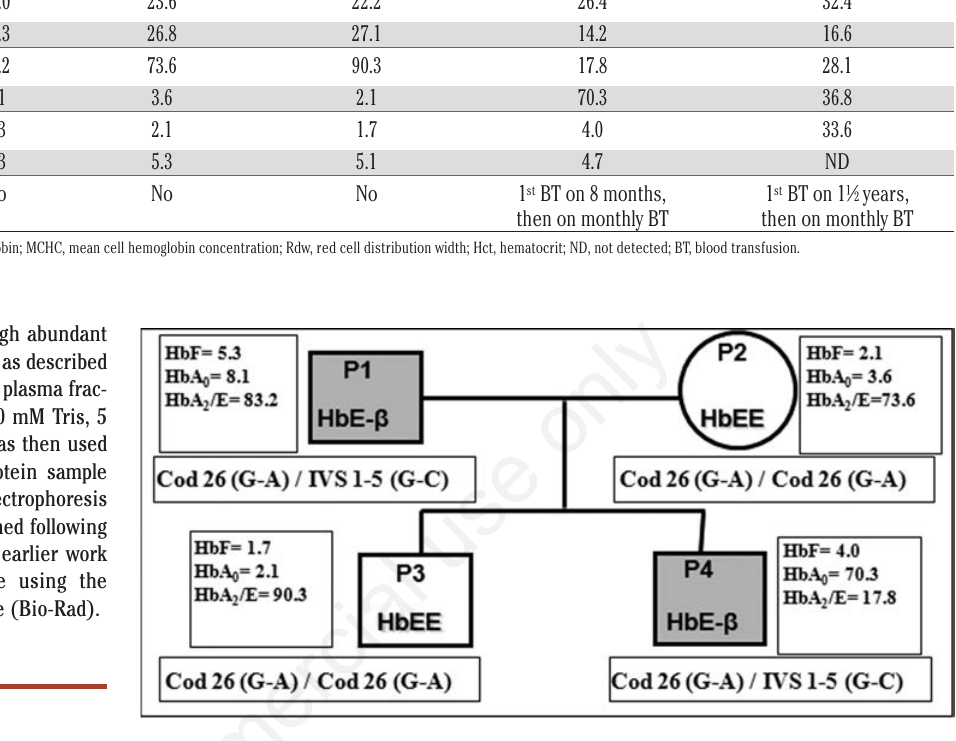
Figure 1. Pedigree of the family along with major clinical and mutational data. Hb, hemoglobin.